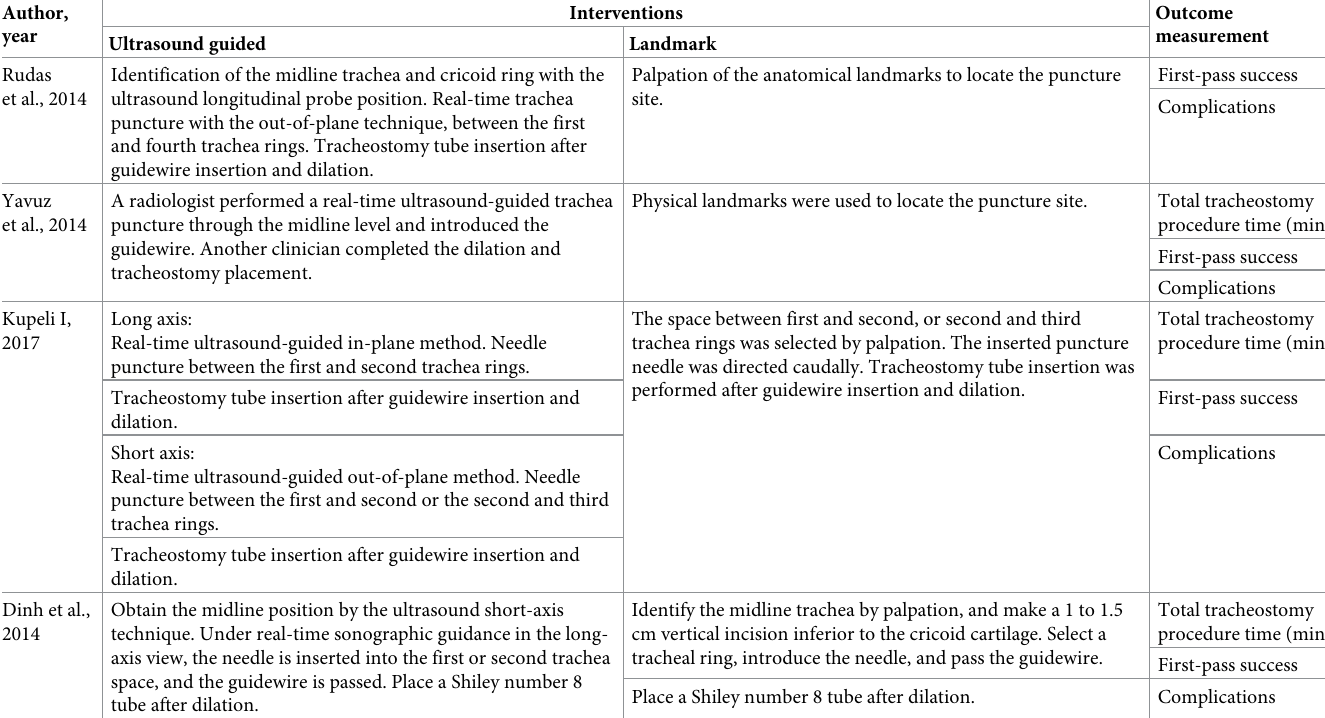
Table 3. Summary of the intervention details in the included